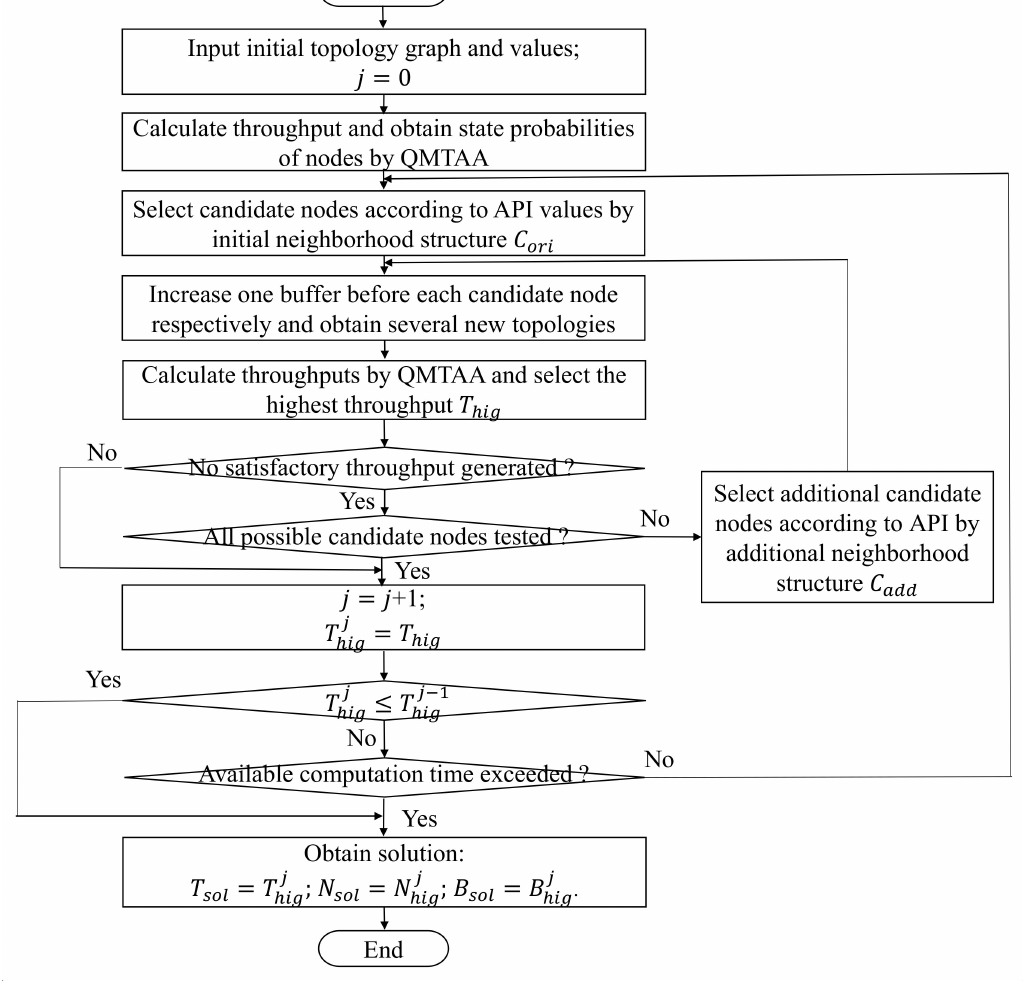
Figure 1. Framework of the bottleneck-based variable neighborhood search